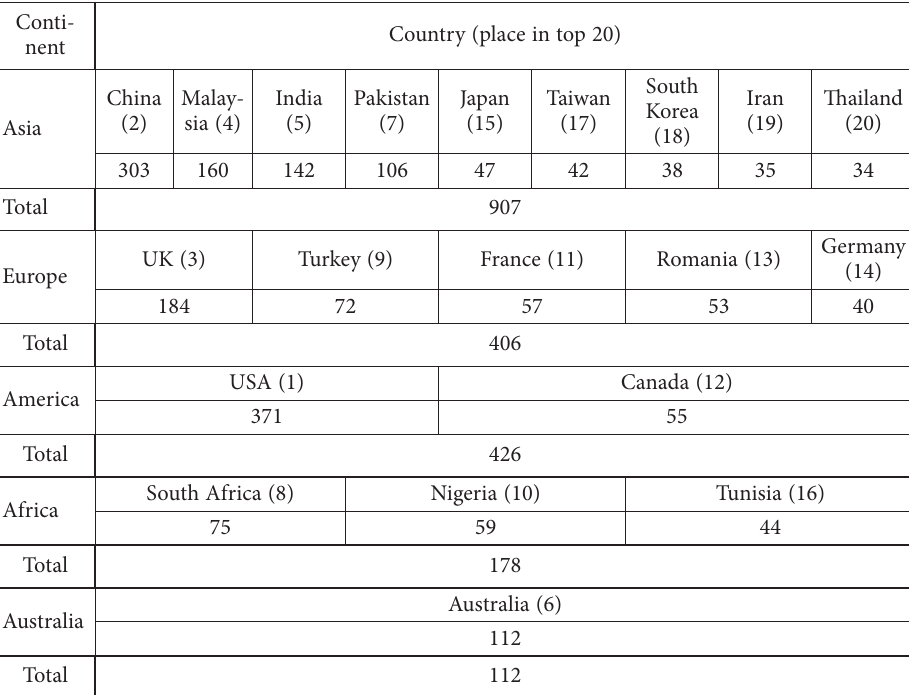
Table 2. Top 20 countries according to their scientific production (source: Scopus) Con ti-